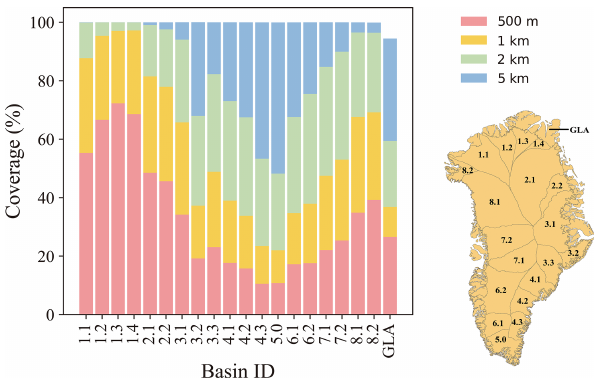
Figure 3. Coverage percentages of calculated elevation grids by ICESat-2 observations of 500m, 1km, 2km, and 5km. The basin boundaries are from Zwally et al. (2002), which divides Green- land into eight main basins, covering approximately 1 . 72 × 10 6 km 2 . Ice caps and glaciers that are not connected with the ice sheet are marked as GLA